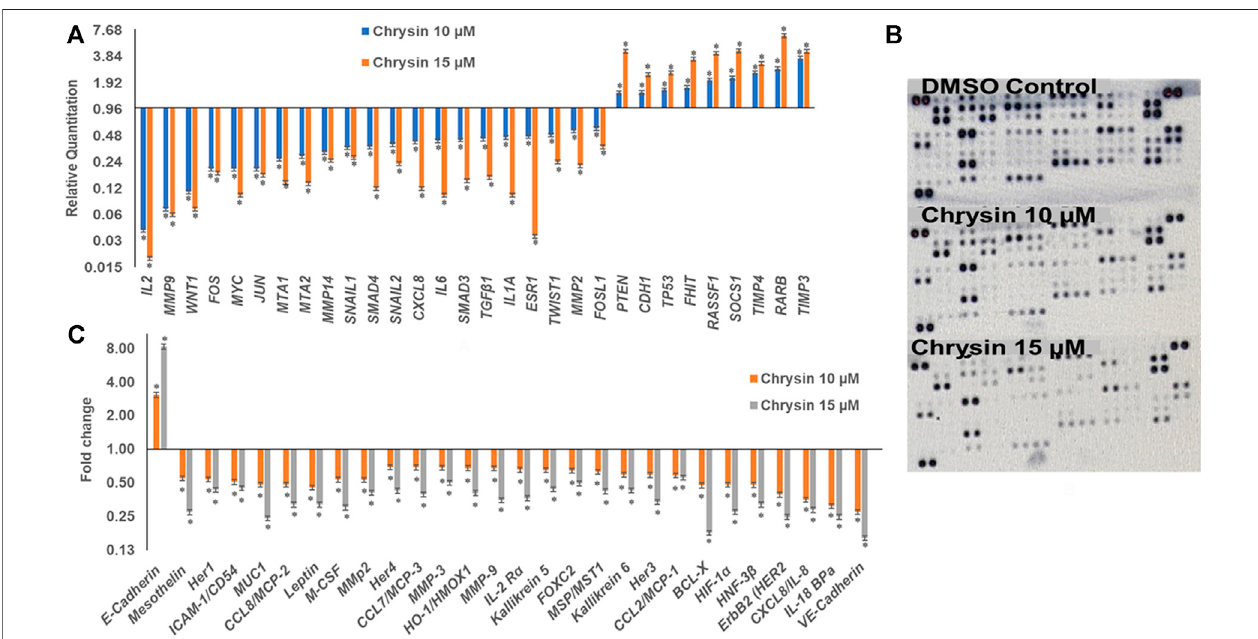
FIGURE3|(A) ChrysinmodulatedtheexpressionofvariousTSGsandmigrationrelatedgenesinadose-dependentmanner.TheTSGswerereactivated,whereas in fl ammatory- and migration-related genes were downregulated. (B) The nitrocellulose membranes depicting the expression of different proteins. (C) Chrysin treatment modulates the proteins related to migration and in fl ammation in a dose-dependent